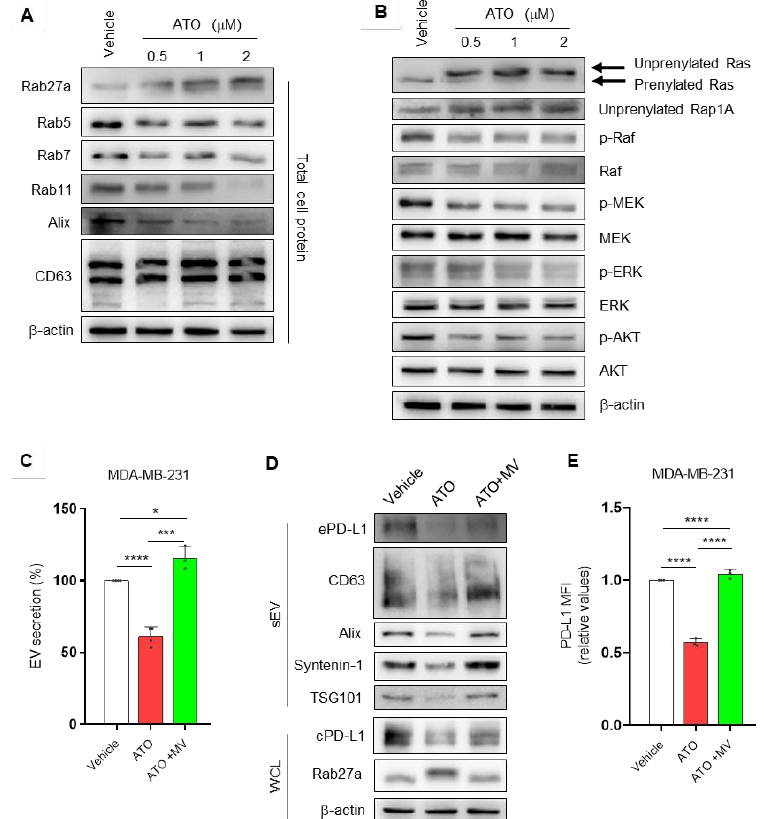
Figure 2. ATO suppresses EV PD-L1 by regulating EV biogenesis and the mevalonate pathway. ( A ) Immunoblot for the indicated Rab family proteins (Rab27a, Rab5, Rab7) and MVB (multivesicular body) marker (Alix, CD63) in MDA-MB- 231 cells. β -actin was used as a loading control for